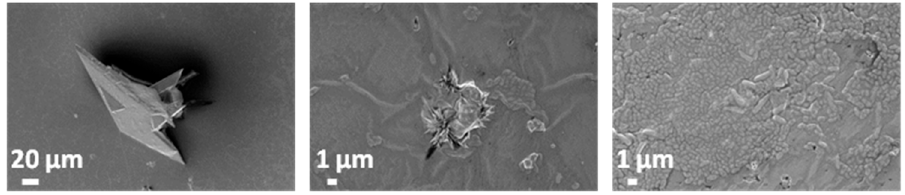
Figure 15. FESEM images of PLA support after immersion in artificial urine for 21 days.